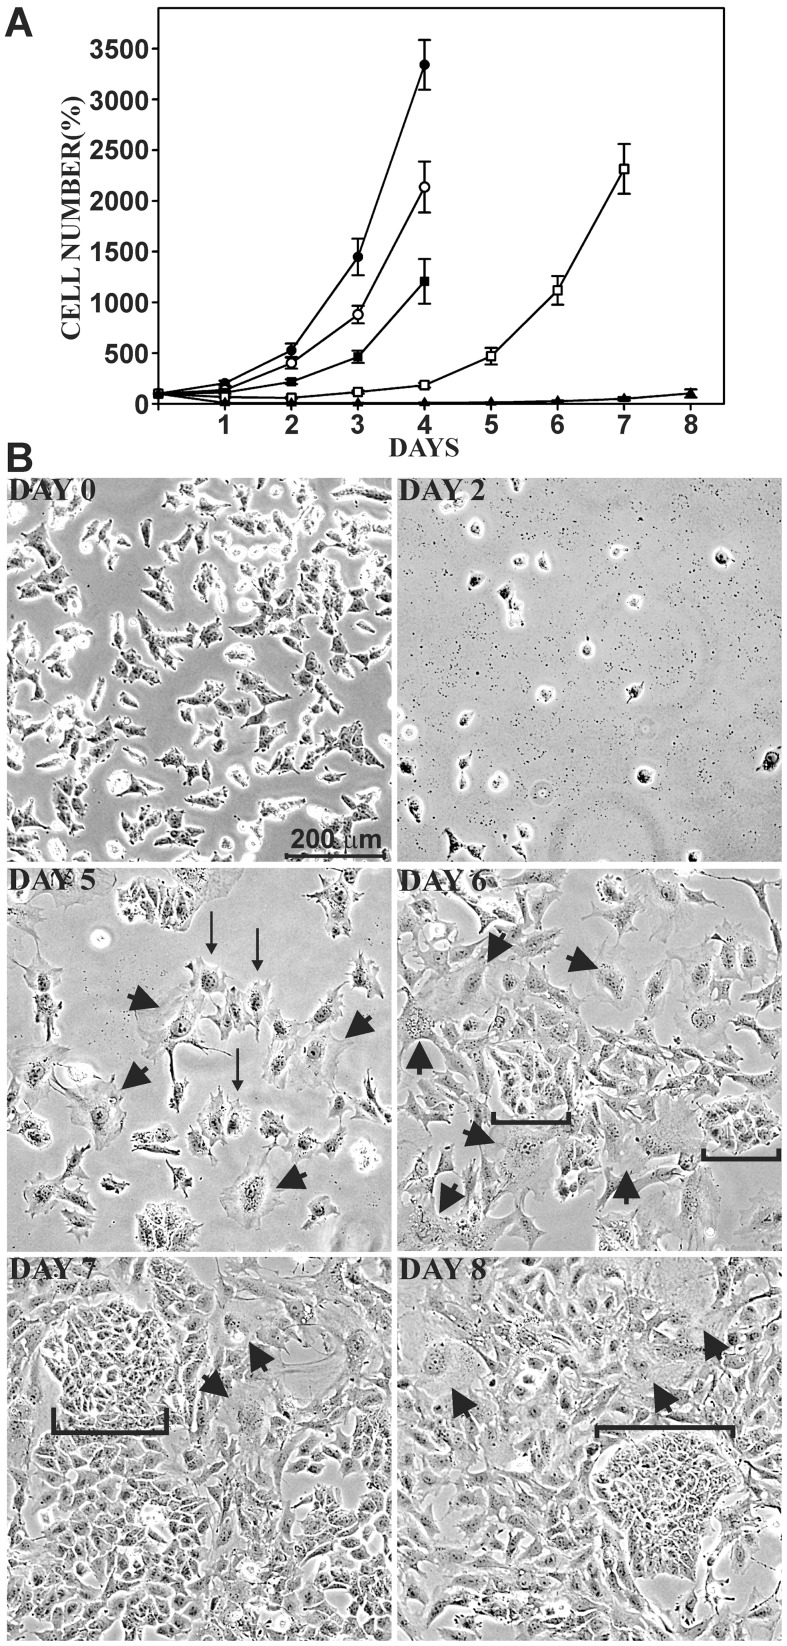
Effect of incubating NT2/D1 cells for short time periods with high concentrations of curcuminoids.(A) Cells were either incubated with standard medium (•) or with medium containing 47 µM curcuminoids (SOLID+DMSO) for 0.5 h (○), 1 h (▪), 2 h (□), or 4 h (▴). The media were then removed, cells washed, and replenished with standard medium. Cells were photographed and counted daily. (B) Phase contrast micrographs of NT2/D1 cells before (day 0) and 2, 5, 6, 7, and 8 days after incubation with 47 µM curcuminoids for 4 h. Arrows point to larger dividing cells and arrowheads to cells reminiscent of a senescent phenotype. Brackets delineate groups of cells that have reverted to the original phenotype (compare Fig. 3).